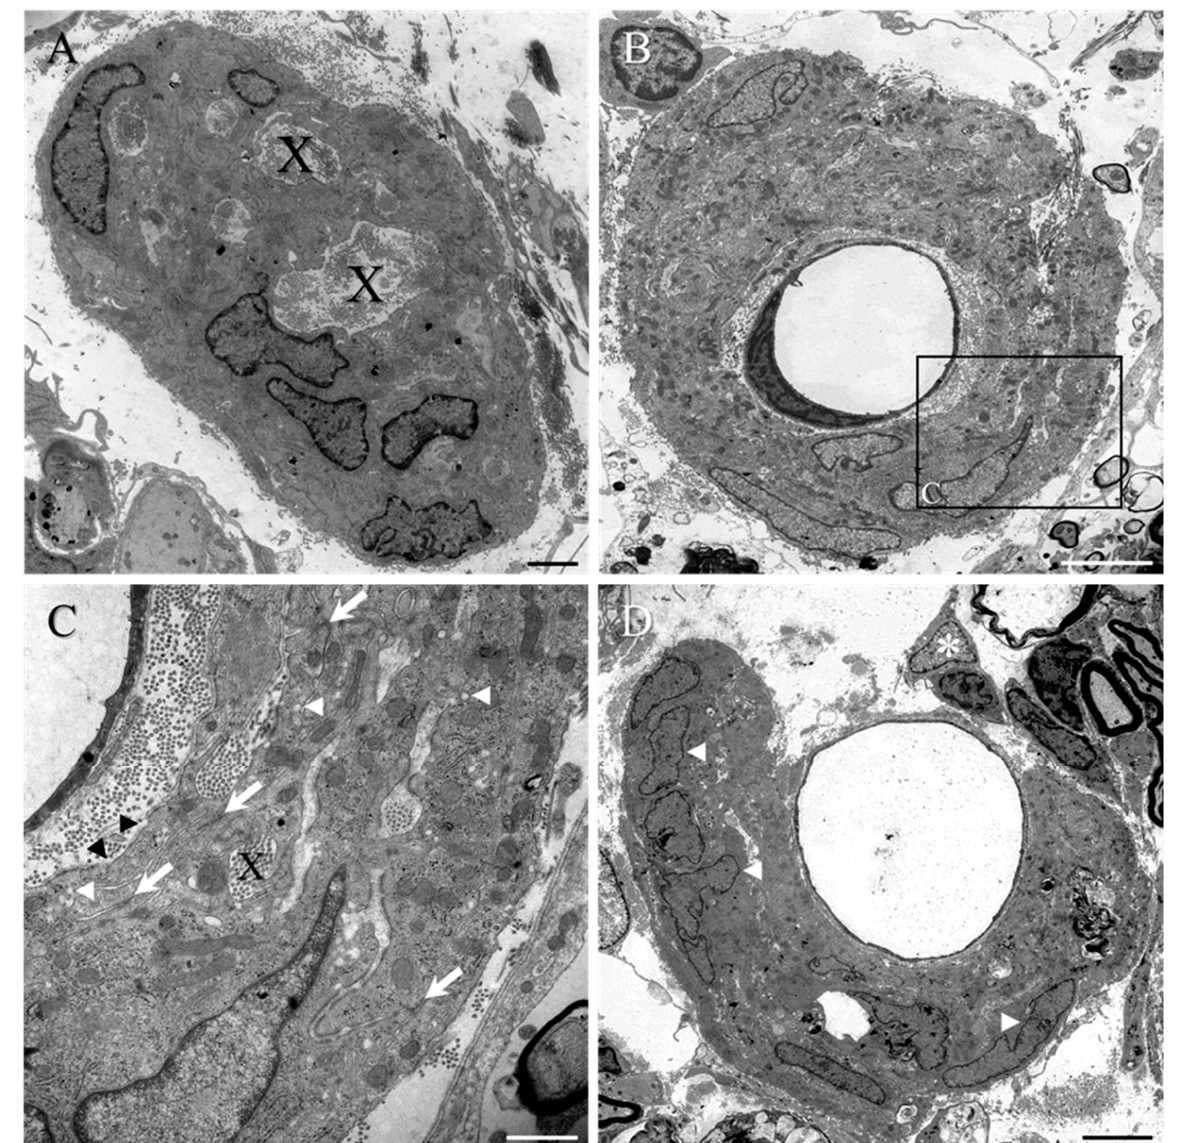
Figure 7. Ultrastructure of PNLC clusters or nests close to the implant of the collagen scaffold-implanted group. ( A ) As typically seen with this population of reactive cells, isolated clusters or nests of reactive PNLC commonly included bundles of collagen fibrils within lacunae (X in A,C). ( B ) Some clusters or nests of PNLC were also observed to totally envelop capillaries within the damaged spinal cord parenchyma. ( C ) High magnification of boxed area in B. Lacunae of trapped collagen (X) were scattered amongst the numerous overlapping processes with tight junctions (white arrows), pinocytic vesicles (white arrowheads), and discontinuous basal lamina (black arrowheads). ( D ) Some clusters only partially enveloped capillary walls. However, the nuclei of the PNLC (white arrowheads) appeared to be distinct when compared to that of a pericyte (asterisk) that had divested itself from the vessel wall. Scale bars: A = 2 µm; B,D = 5 µm; C = 1 µm.